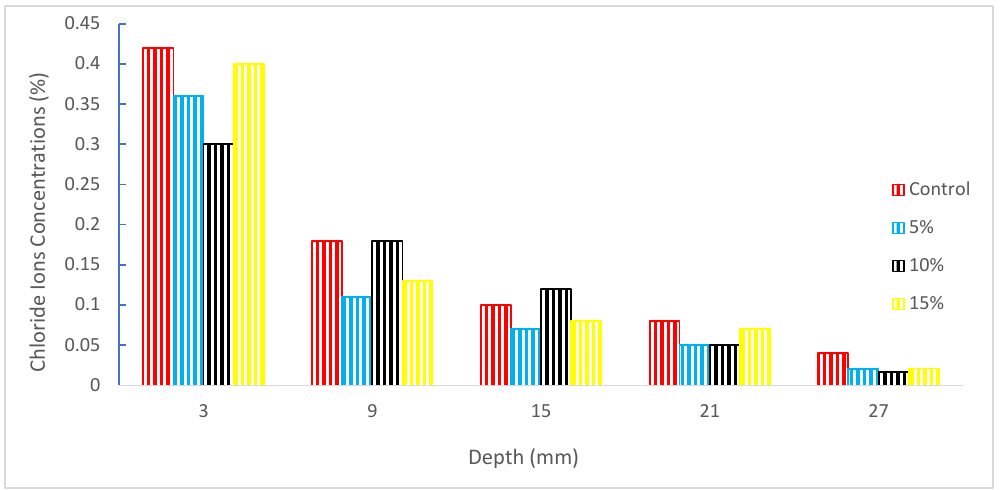
Figure 20. Chloride ion penetration: data source [109].